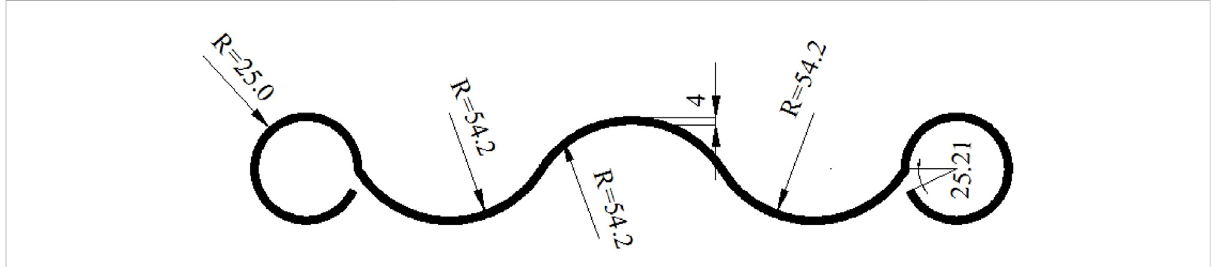
FIGURE 1 Cross section of the three-wave beam steel